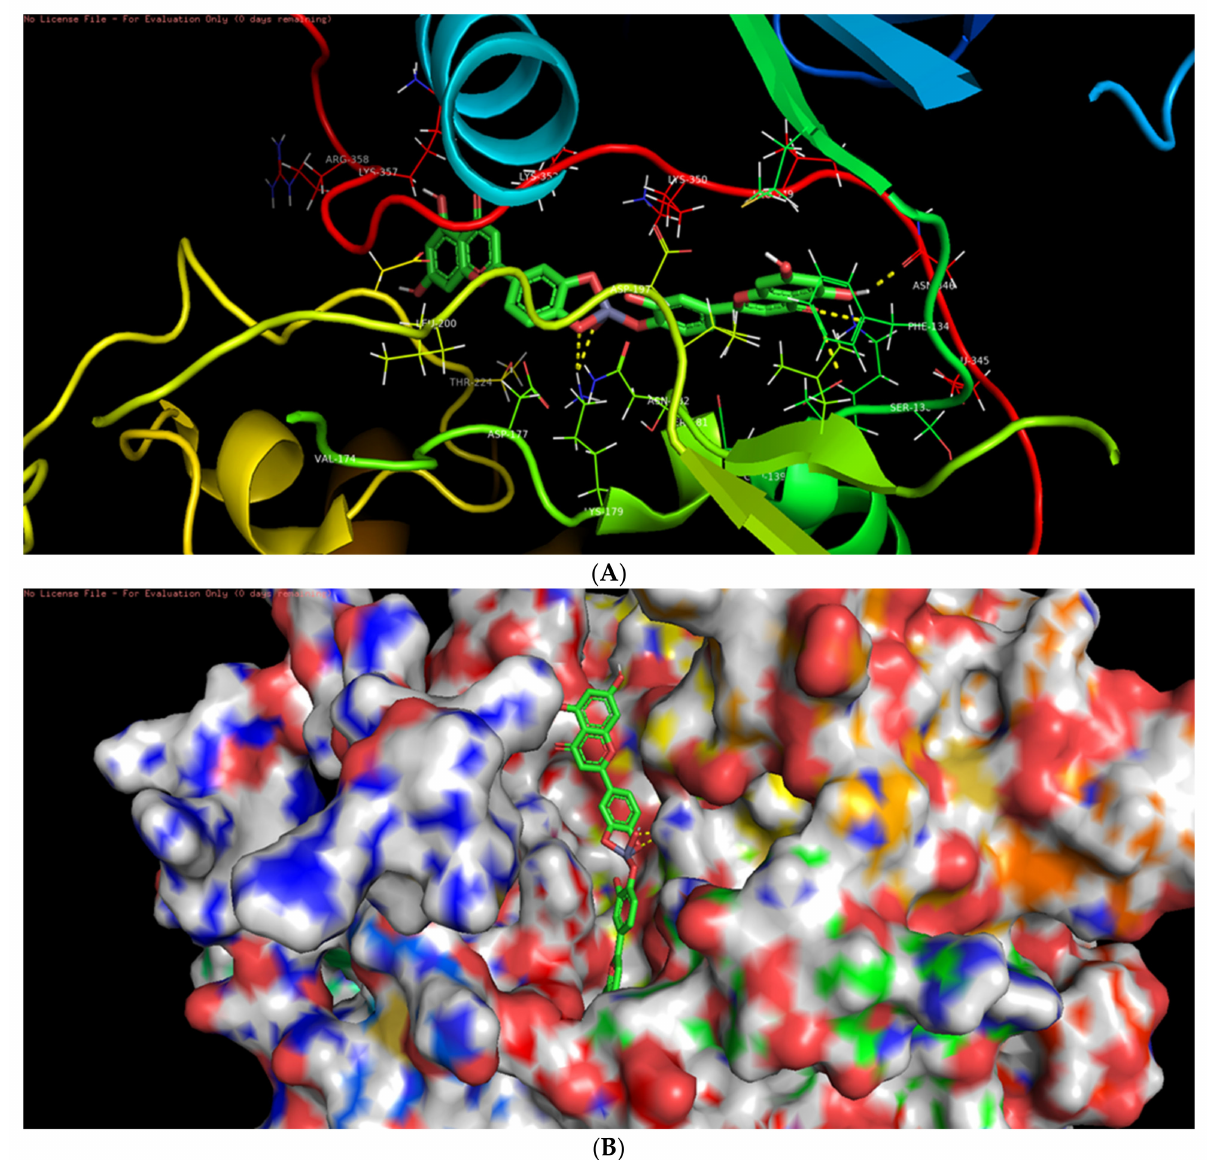
Figure 11. ( A ) The bonded and non-bonded interactions of L-ZnONPs with the cancer protein 2LAV. ( B ) The best-docked pose of L-ZnONPs bound to the hydrophobic preset of the 2LAV